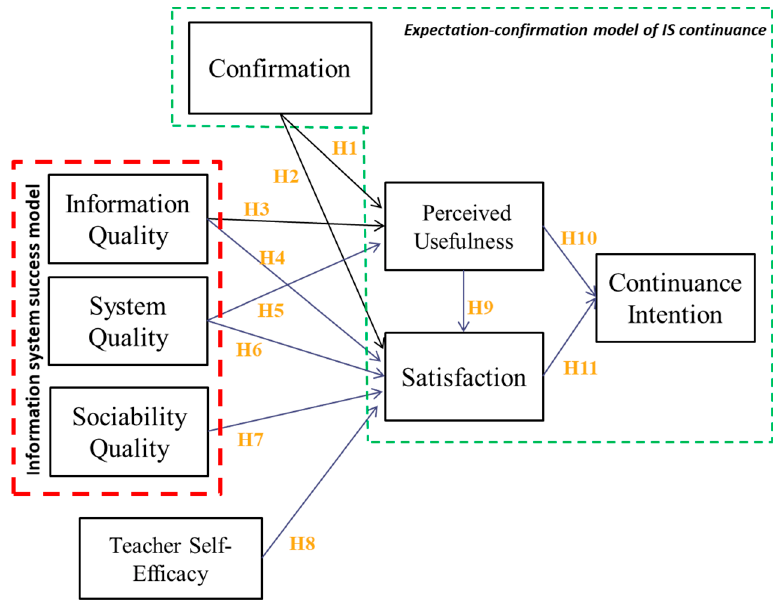
Figure 2. Conceptual Model of Continuance Intention.